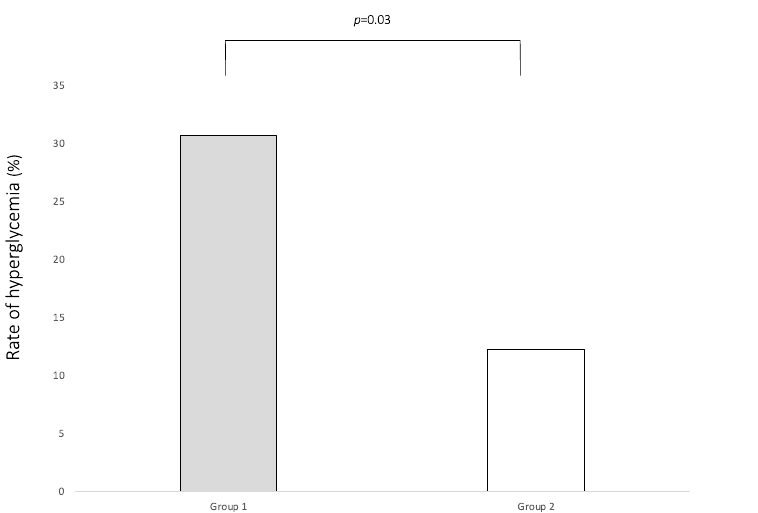
Figure 2. Macronutrient intake administered through PN during the first week of life. Figure legend: * p -value < 0.05. The rate of HG within 0–7 DoL is reported in Figure 3.